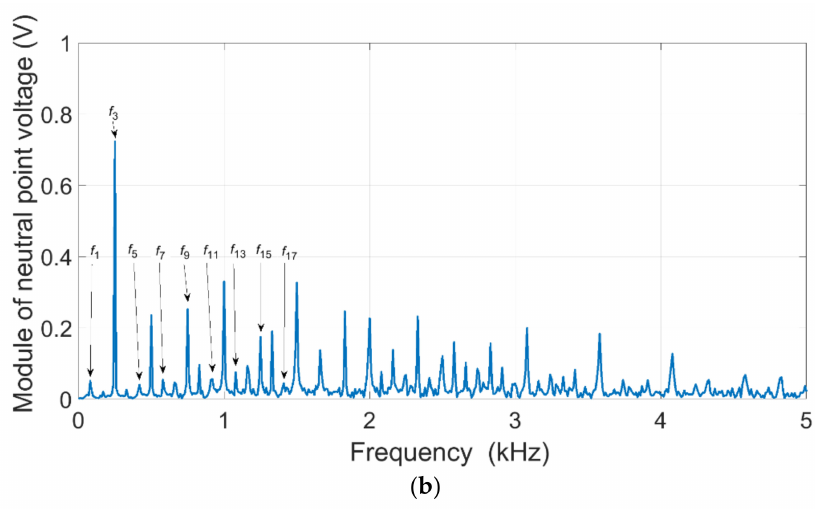
Figure 16. Y (cid:52) configurations—FFT of neutral voltage—healthy: ( a ) numerical calculations, ( b ) measurement.